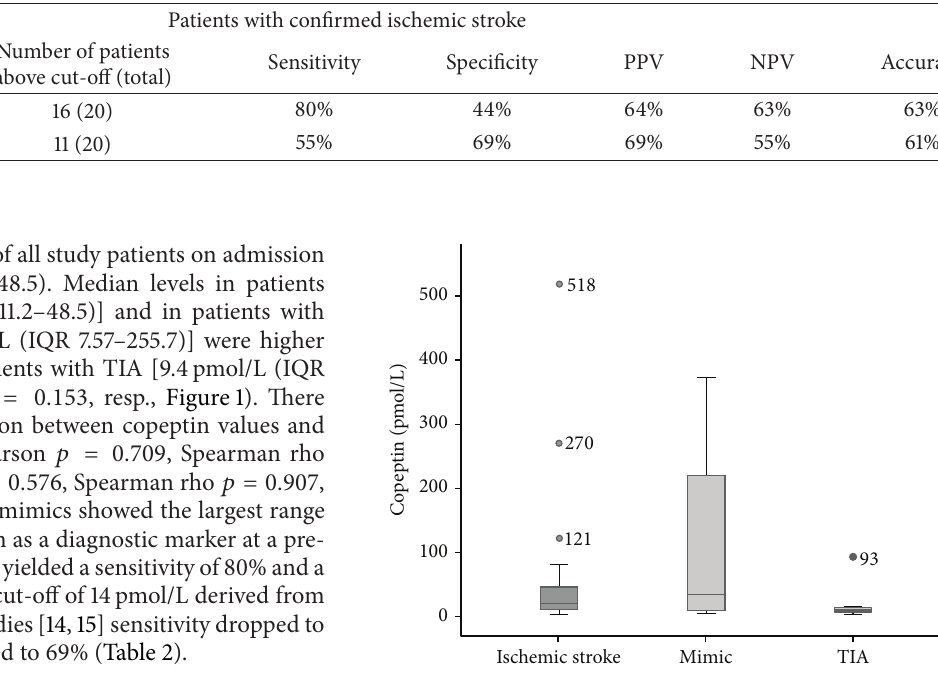
Figure 1: Copeptin-levels of patients with ischemic stroke, stroke- mimics, and